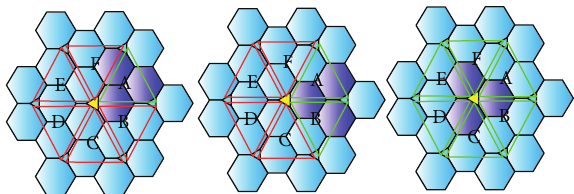
Figure 8: Dark hexagons denote the three network wide strongest BSs. Depending on their distribution, an MS can be scheduled into one, two, or six different cover shifts.